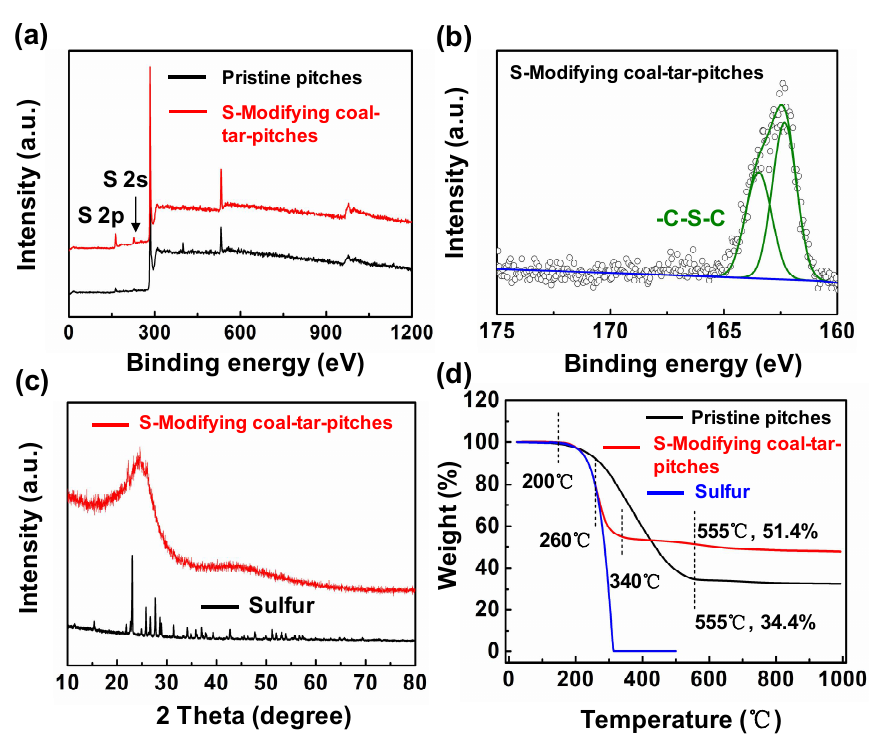
Figure 1. XPS results of pristine pitch and S-modifying coal-tar-pitches ( a ), Fitting result of the XPS data of S-modifying coal-tar-pitches ( b ). XRD results of S-modified coal-tar-pitch and sulfur ( c ). TGA results of pristine pitch, S-modified coal-tar-pitch and sulfur ( d ).